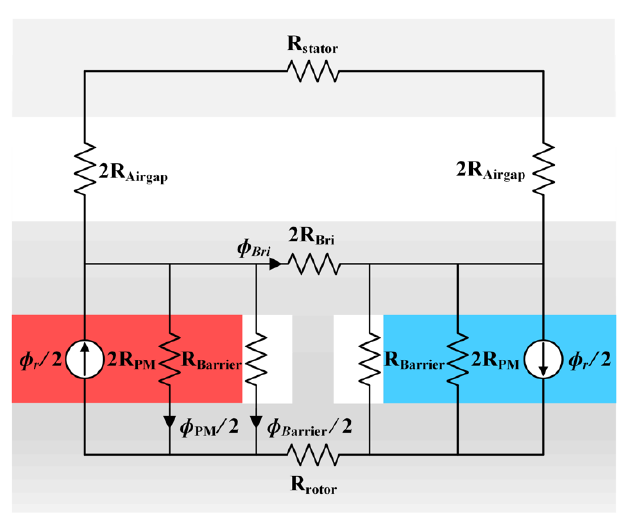
Figure 3. The shape of analysis model with assumptions.